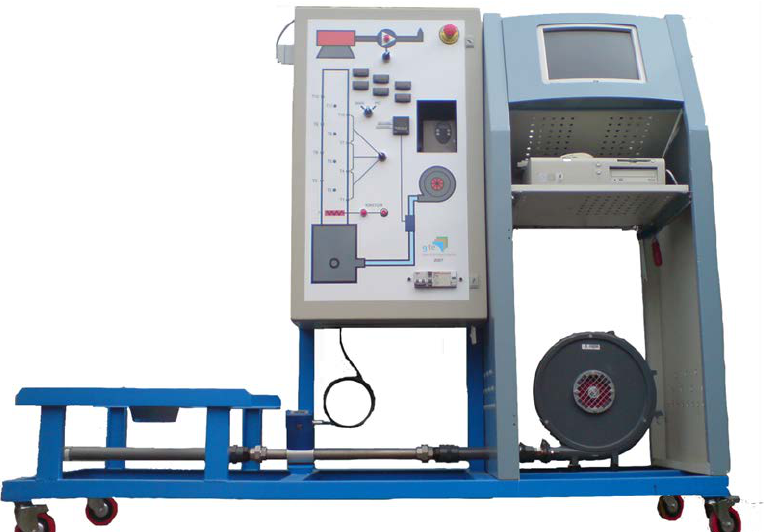
Figure 2. Power and control